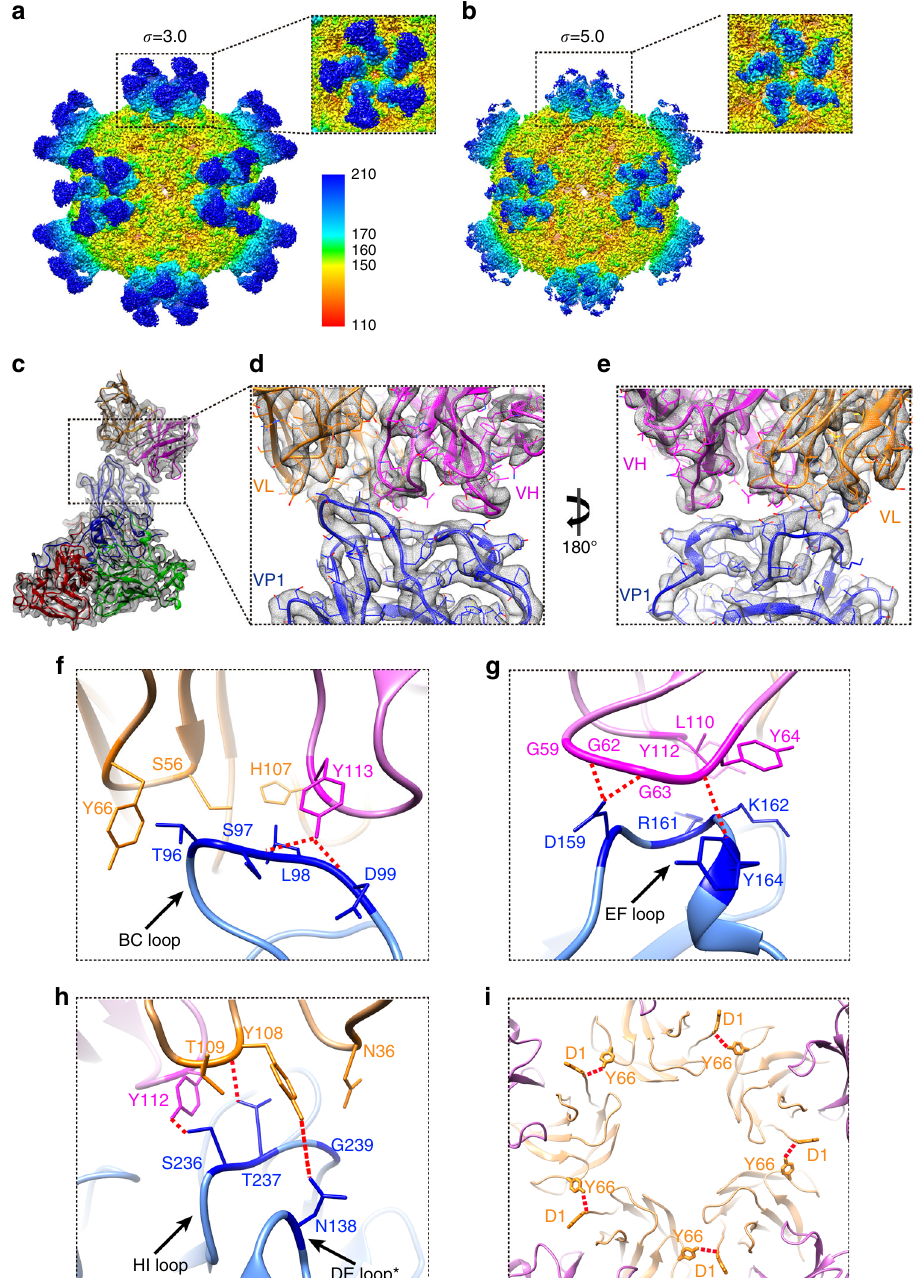
Fig. 5 CryoEM map and atomic model of CVA6 A-particle complexed with Fab-1D5. a , b The isosurface views (radially colored) along a 2-fold axis of the CVA6-Fab cryoEM density map displayed at two different contour levels: σ = 3.0 a and σ = 5.0 b . The variable ( light blue ) and constant ( dark blue ) domains of each Fab can be seen in a , but most of the constant domain disappears at the higher threshold level b owing to the fl exibility at the elbow region of the Fab. c Segmented immune-complex density map ( gray ) and fi tted atomic models (ribbon diagrams) of three capsid proteins and the variable domain (light chain, orange ; heavy chain, magenta ) of the Fab-1D5. d , e Close-up view of the interaction interface involving fi ve of six CDRs on the Fab and four surface loops of VP1. f – h Expanded views of the virus-Fab interaction interface close to the BC f , EF g , and HI loops h of VP1. Potential H-bonds are marked by red dashed lines. Residue Y108 in the Fab light chain can form a H-bond with T237 on EF loop and also N138 on the DE loop (black asterisk) of the adjacent VP1 capsid protein h . i Inside view of the fi ve Fab molecules shows the potential H-bond formed between D1 and Y66 from two adjacent light